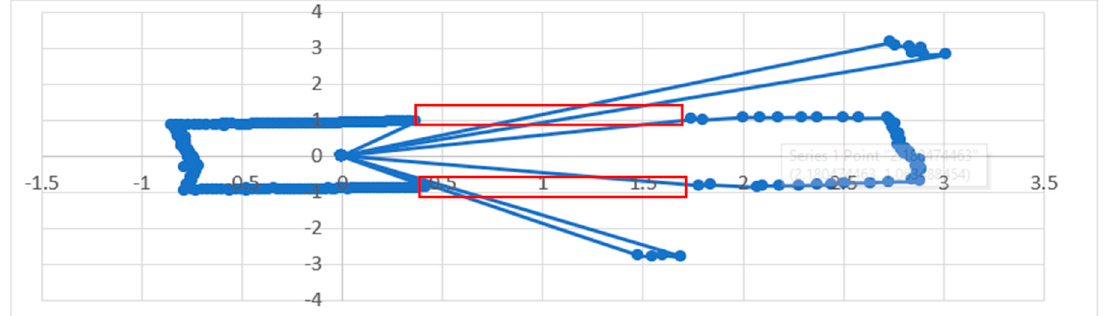
Figure 17. The 360 received intensity laser scan points mapped linearly for the Figure 16.